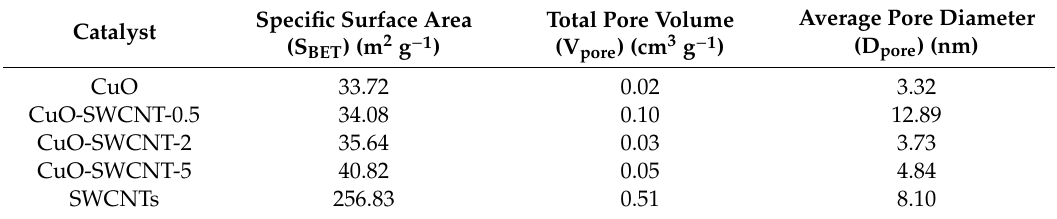
Table 1. Experimentally determined values of specific surface area (S BET ), total pore volume (V pore ), and average pore diameter (D pore ).